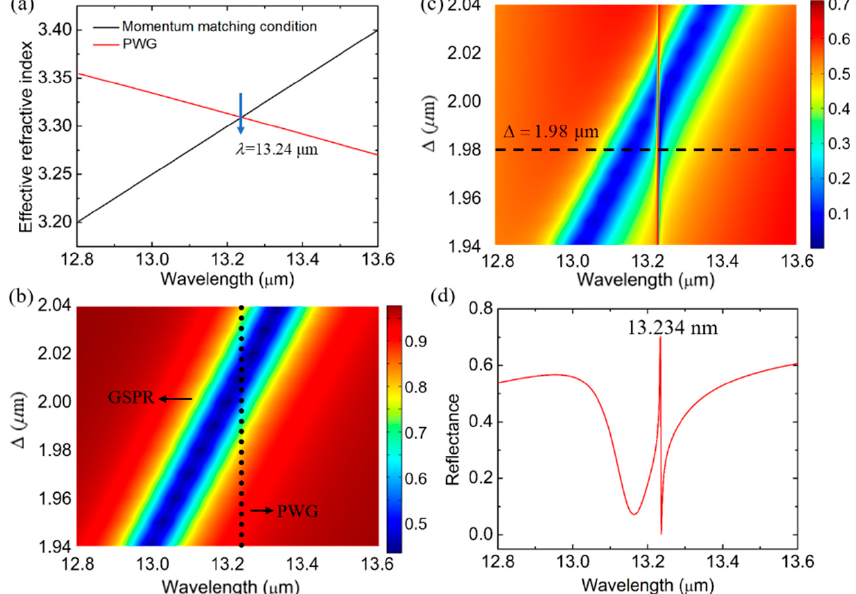
Figure 2. ( a ) Effective refractive index of PWG mode (red-line) and the momentum-matching condition supported by graphene grating (black-line). ( b ) The transmittance contour plot of wavelengths and Δ of the structure that is composed of periodic monolayer graphene nanoribbons and a CaF 2 substrate. ( c ) The reflectance contour plot of wavelengths and Δ of the proposed structure. ( d ) The reflectance at Δ = 1.98 μ m.